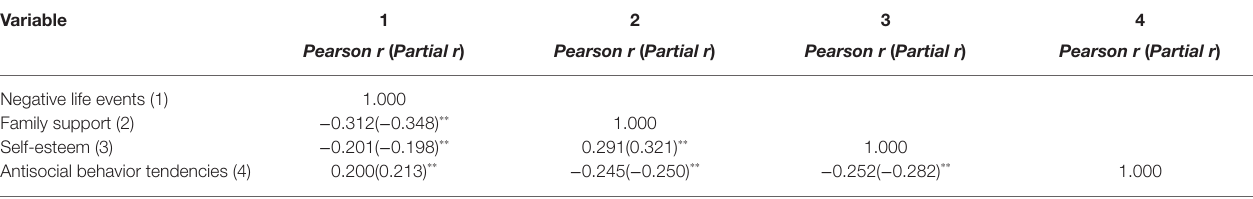
TABLE 1 | Correlation analysis between negative life events, self-esteem, family support, and antisocial behavior tendencies.